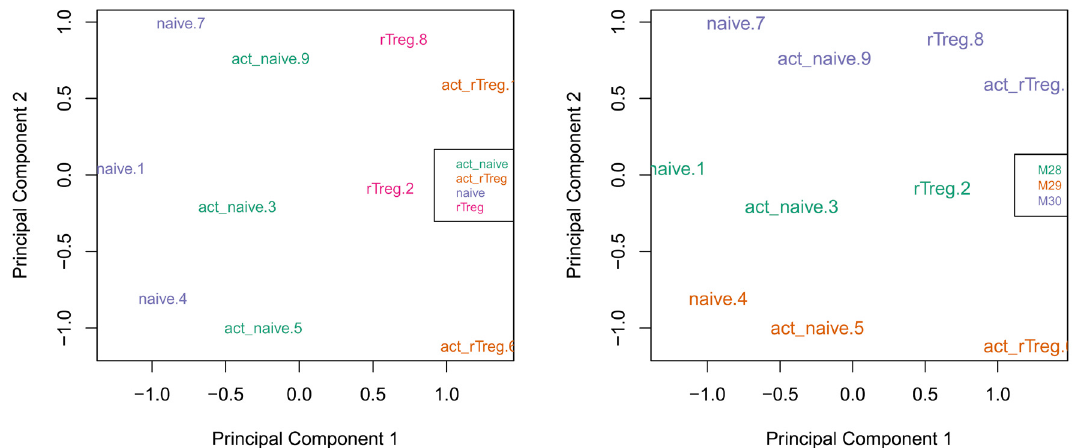
Figure 6. Removing SNP-affected CpGs probes from the data changes the sample clustering in the MDS plots.